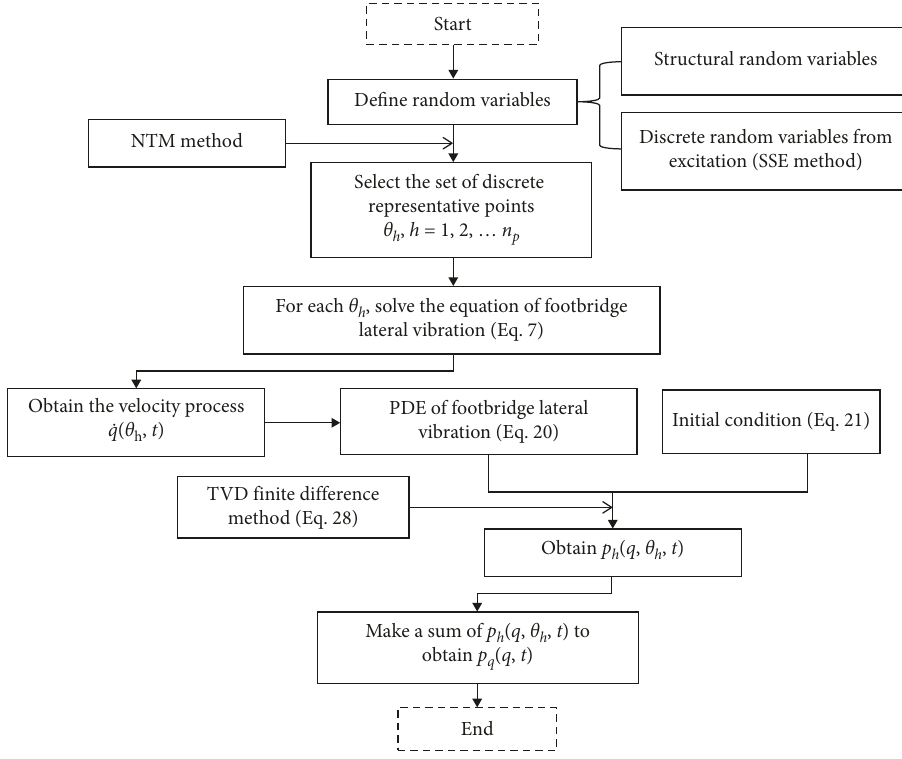
Figure 4: Flowchart of the proposed method.